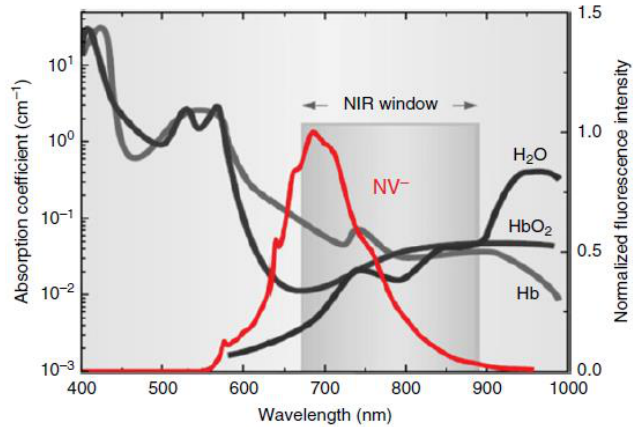
Figure 13. Fluorescence spectrum (red curve) of NDs superimposed on the near-infrared window of biological tissues. The black and gray curves are the absorption spectra of water (H 2 O), oxygen bound hemoglobin (HbO 2 ), and hemoglobin (Hb), respectively. Reprinted with permission from [87], Elsevier, 2012.